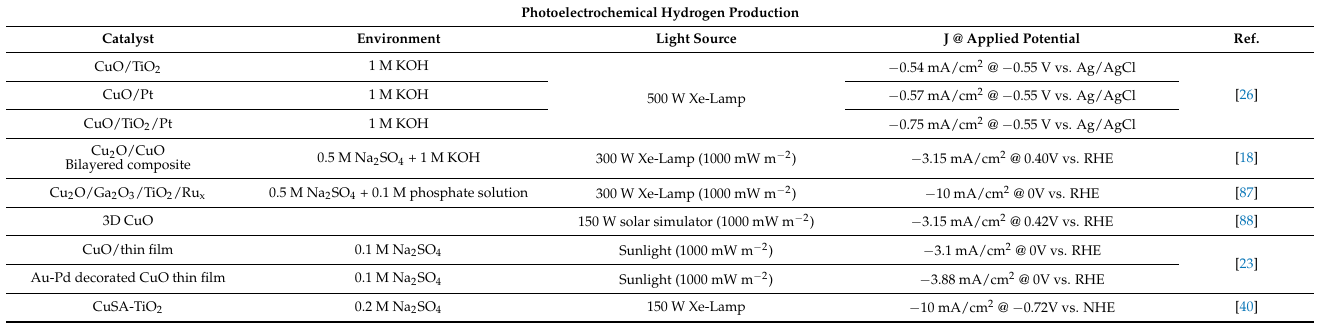
Table 4. Pertinent Cu-based materials for PhotoElectrochemical Hydrogen Evolution Reaction based on their catalytic activity.